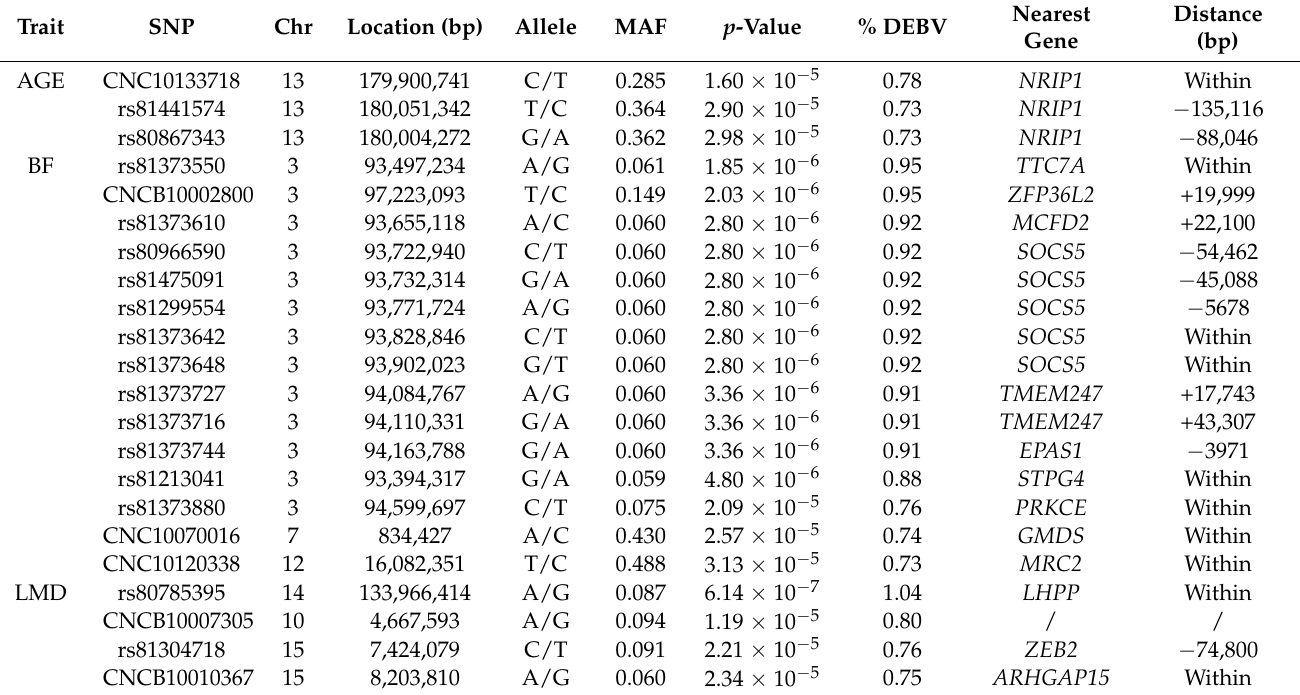
Table 3. Summary information of significant dominance SNPs for AGE, BF, and LMD.